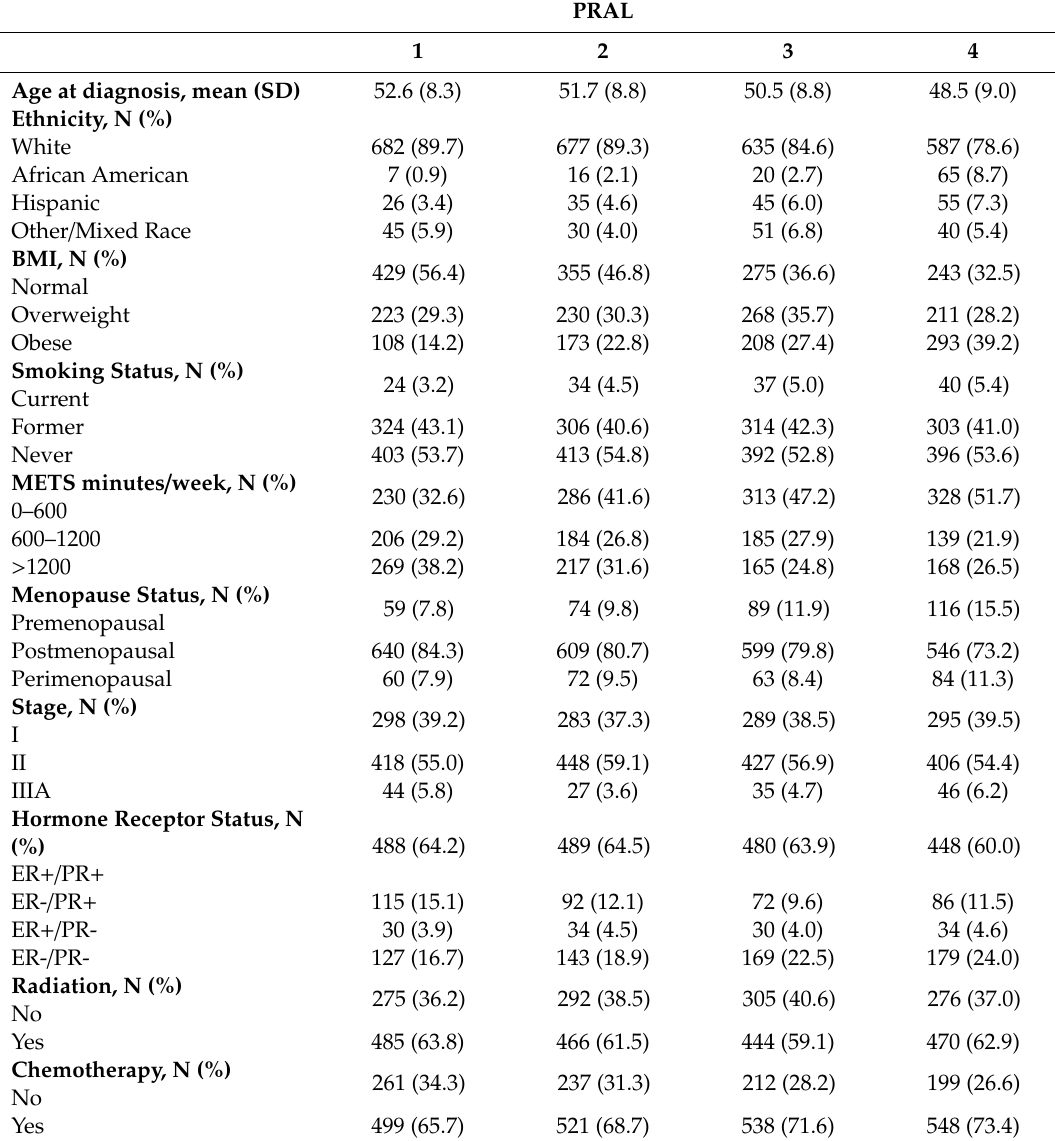
Table 2. Descriptive statistics of breast cancer survivors in the WHEL cohort by quartile of Potential Renal Acid Load (PRAL) ( n =